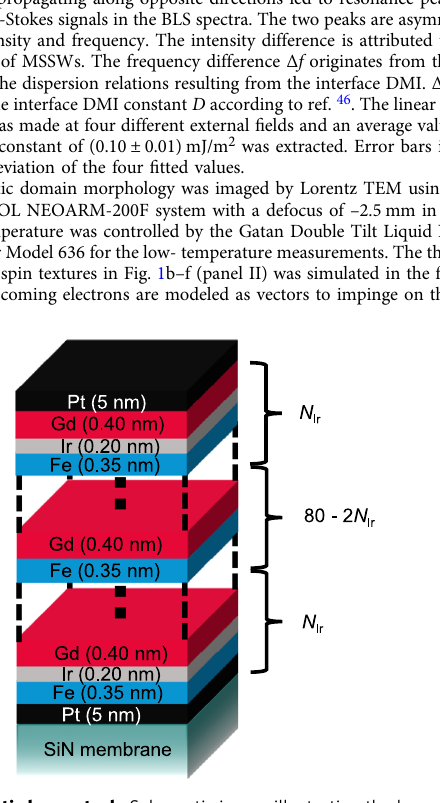
Fig. 7 Schematic layer stack. Schematic image illustrating the layer stack of the different Fe/Gd-based multilayers with Ir insertion layers.